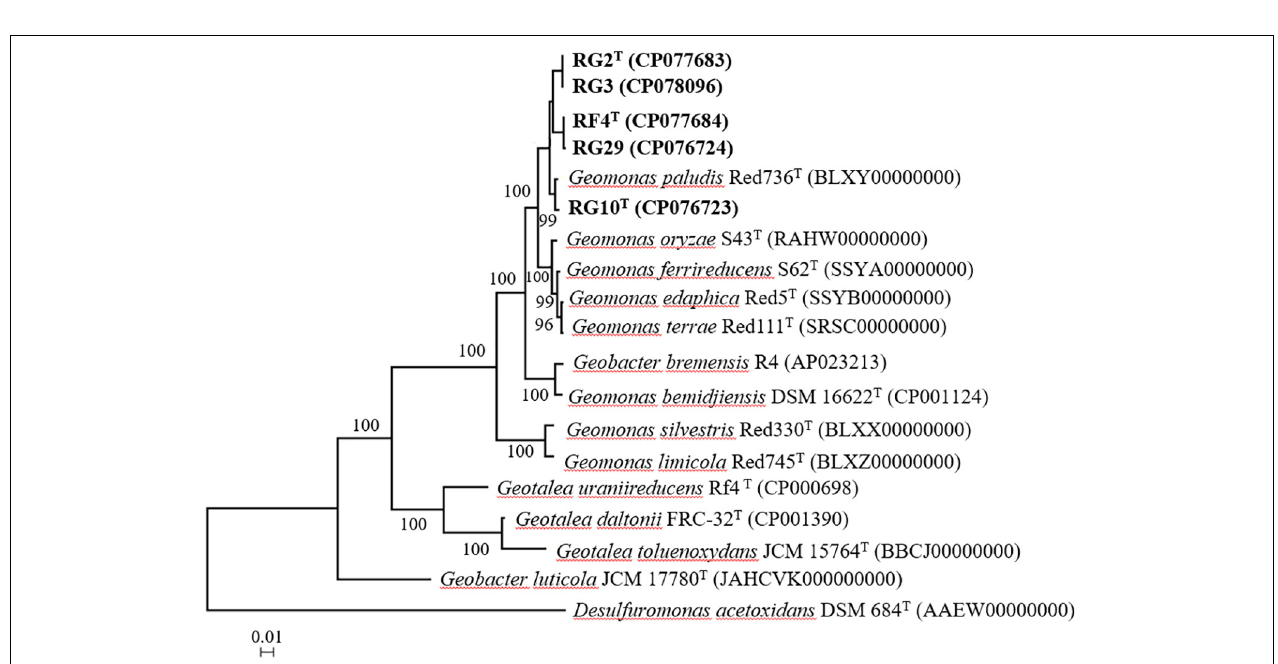
FIGURE 2 | Phylogenomic tree based on the amino acid sequences of 38 ribosomal proteins of five strains and their closely related strains. Bootstrap values (expressed as percentages of 1,000 replications) greater than 50% are shown at branch points. Bar, 0.01 substitutions per nucleotide position. Desulfuromonas acetoxidans DSM 684 T is used as an outgroup. Number in the parenthesis is the genome accession number.